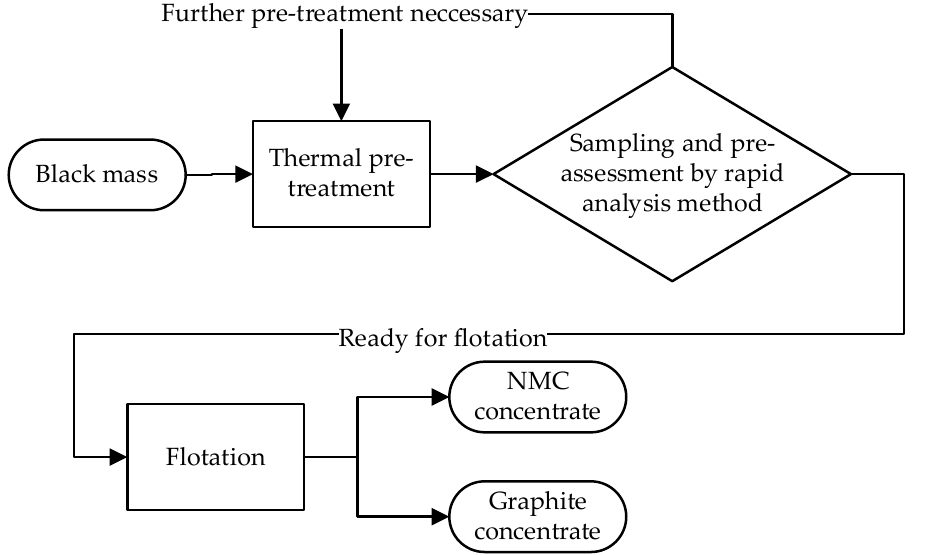
Figure 14. An example flow chart with the rapid analysis method integrated into the process.